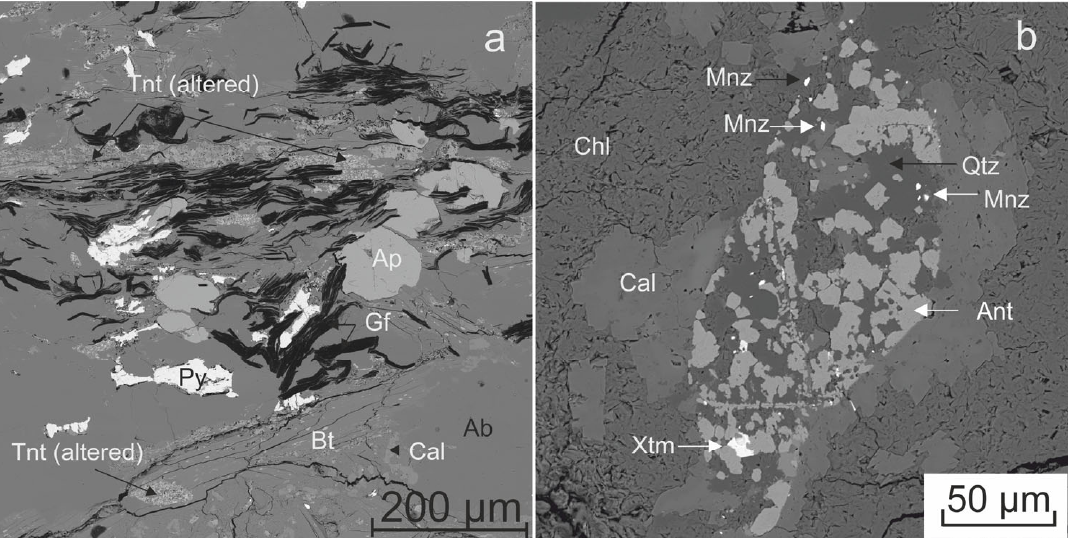
Figure 5 ( a ): The BSE image of the chloritized and graphitized host rock with hydrothermally decomposed titanite grains. ( b ): Close-up of the hydrothermally altered titanite grain decomposed to anatase, quartz, calcite, monazite, and xenotime (white grains) in the chloritized matrix of the host rock of the synchysite-bearing vein. Explanation of symbols: Ap: apatite; Ab: albite; Ant: anatase; Bt: biotite (chloritized); Cal: calcite; Gf: graphite; Ch: chlorite; Mnz: monazite; Py: pyrite; Tnt (altered): hydrothermally altered titanite; Xtm: xenotime.